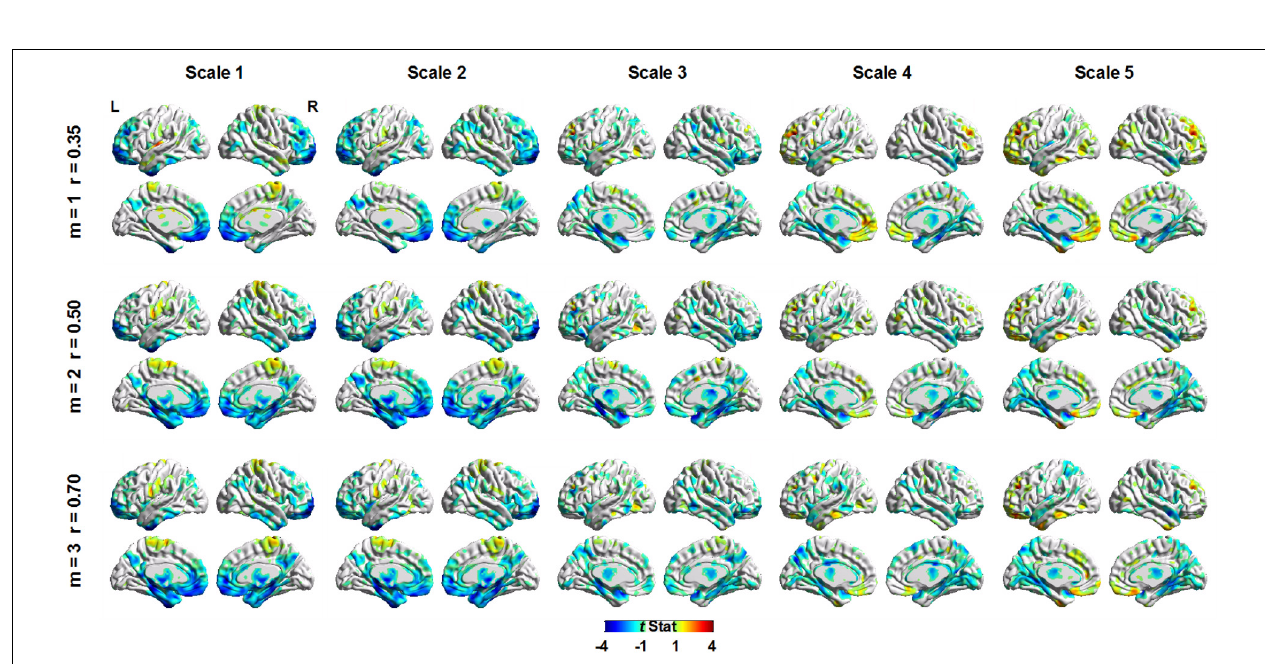
FIGURE 5 | Voxel-wise correlation between age and multiscale entropy using a general linear model (GLM) to control the effect of sex and total gray matter volume. The GLM was used separately for sample entropy parameters of m = 1, r = 0.35; m = 2, r = 0.50; and m = 3, r = 0.70.